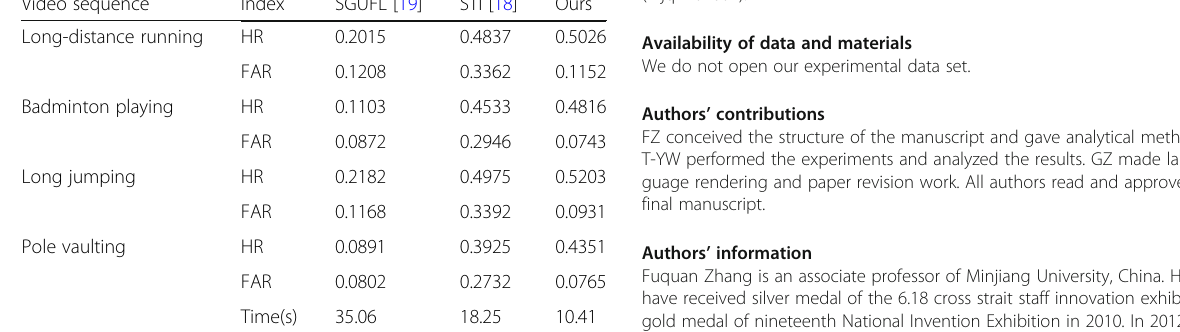
Table 1 Comparison of the performance of the three methods Video